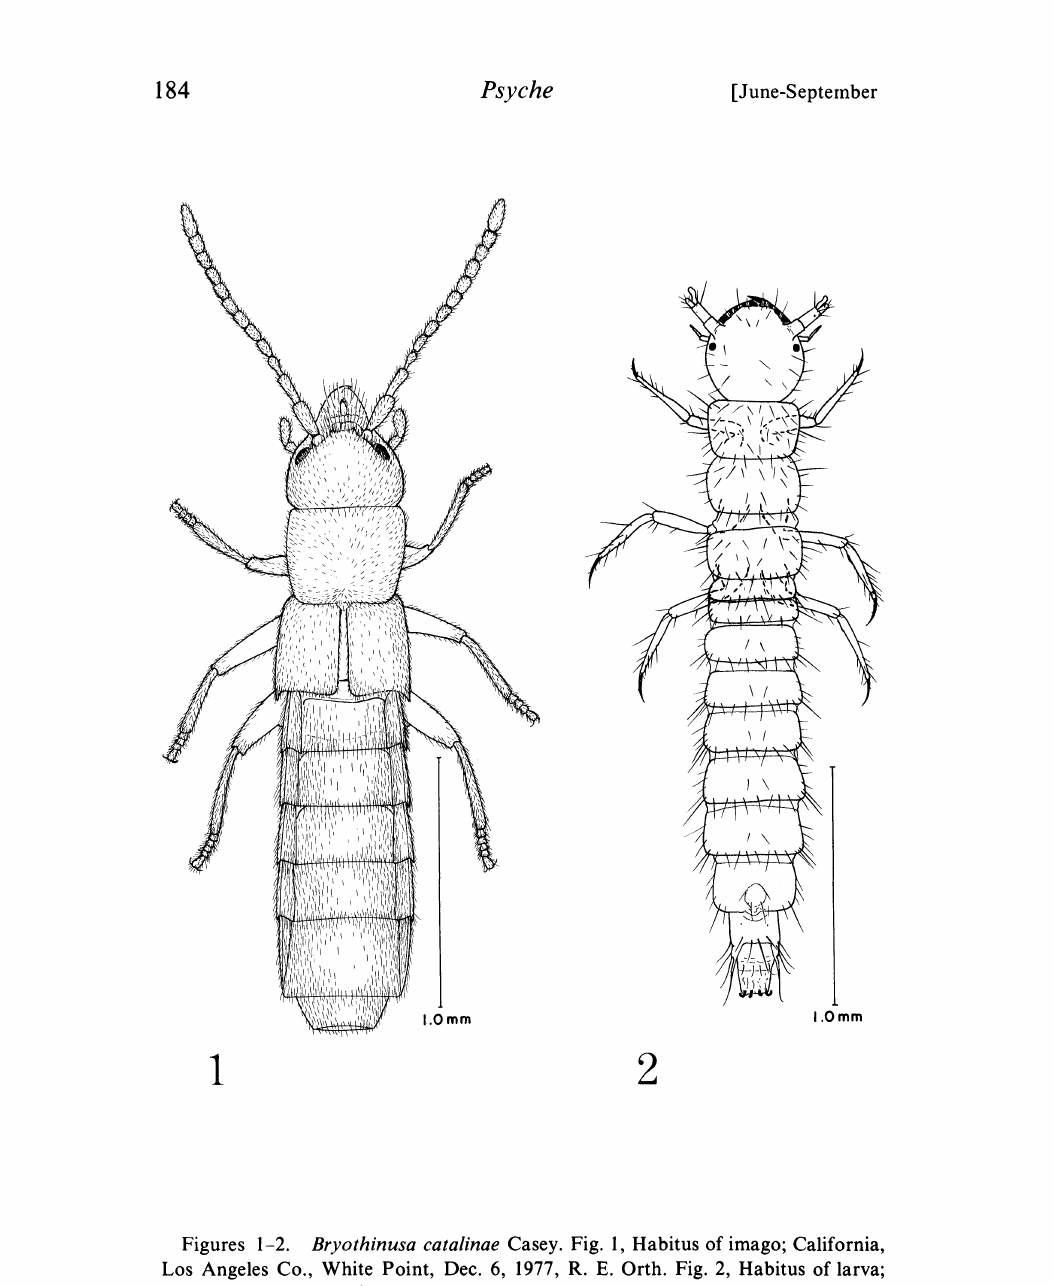
Figures 1-2. Bryothinusa catalinae Casey. Fig. 1, Habitus of imago; California, Los Angeles Co., White Point, Dec. 6, 1977, R. E. Orth. Fig. 2, Habitus of larva; same locality data as